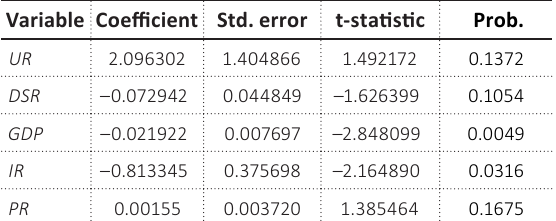
Table 2. The impact of each independent financial bank variable on